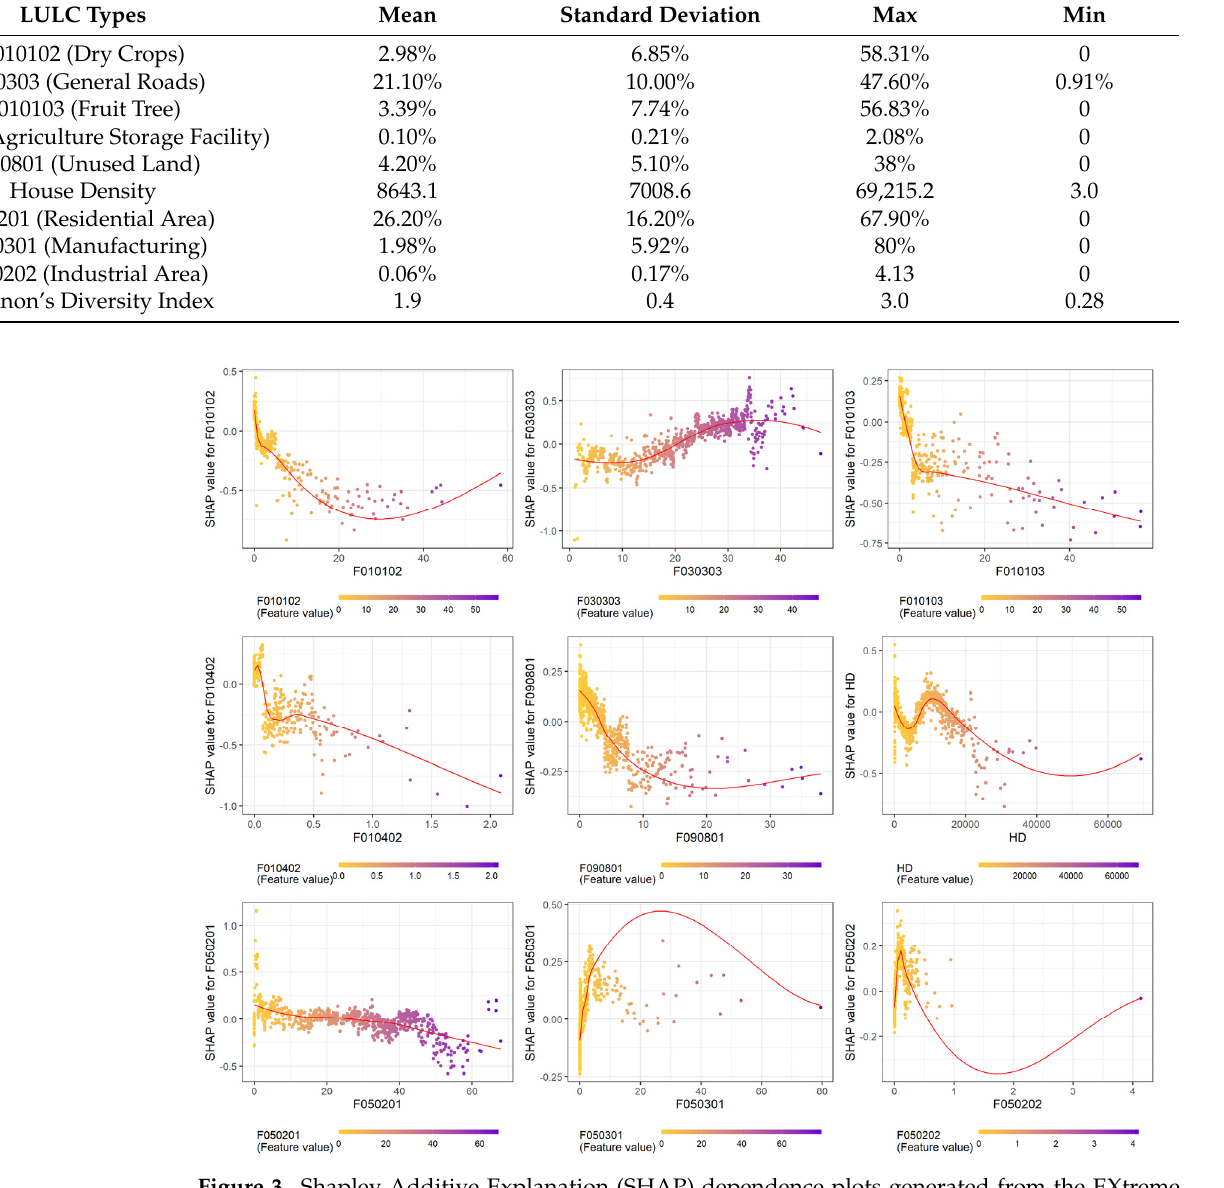
Figure 3. Shapley Additive Explanation (SHAP) dependence plots generated from the EXtreme Gradient Boosting model demonstrate the relationships between the land-use land-cover types and dengue incidence based on the ten most essential variables in Figure 2 and Table 1 (purple color indicates a higher value of corresponding variables and yellow color indicates lower value). The SHAP dependence plot of Shannon’s diversity index is listed in Figure S1 for better typesetting arrangement. A positive SHAP value indicates a higher dengue transmission risk. The plots were smoothed using locally estimated scatterplot smoothing (red